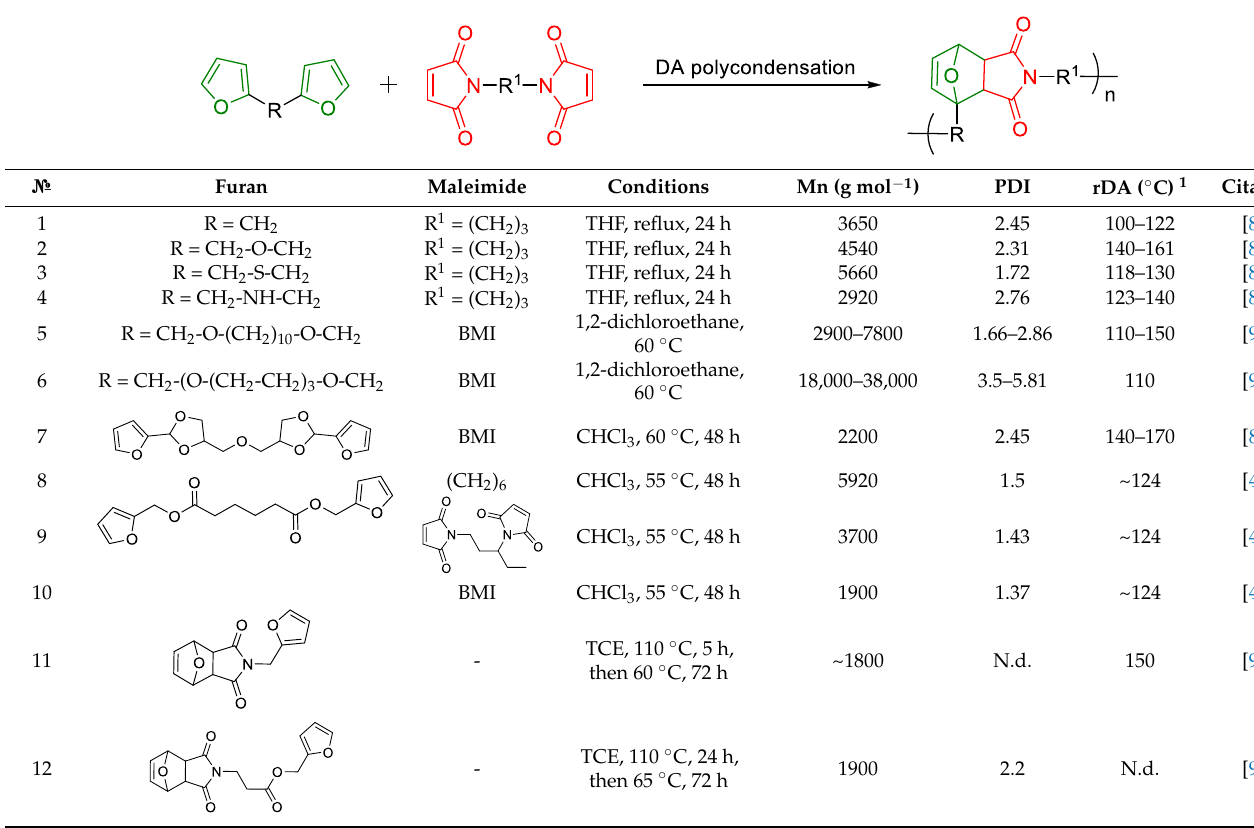
Table 4. Synthesis of linear polymers using the fmDA polycondensation.